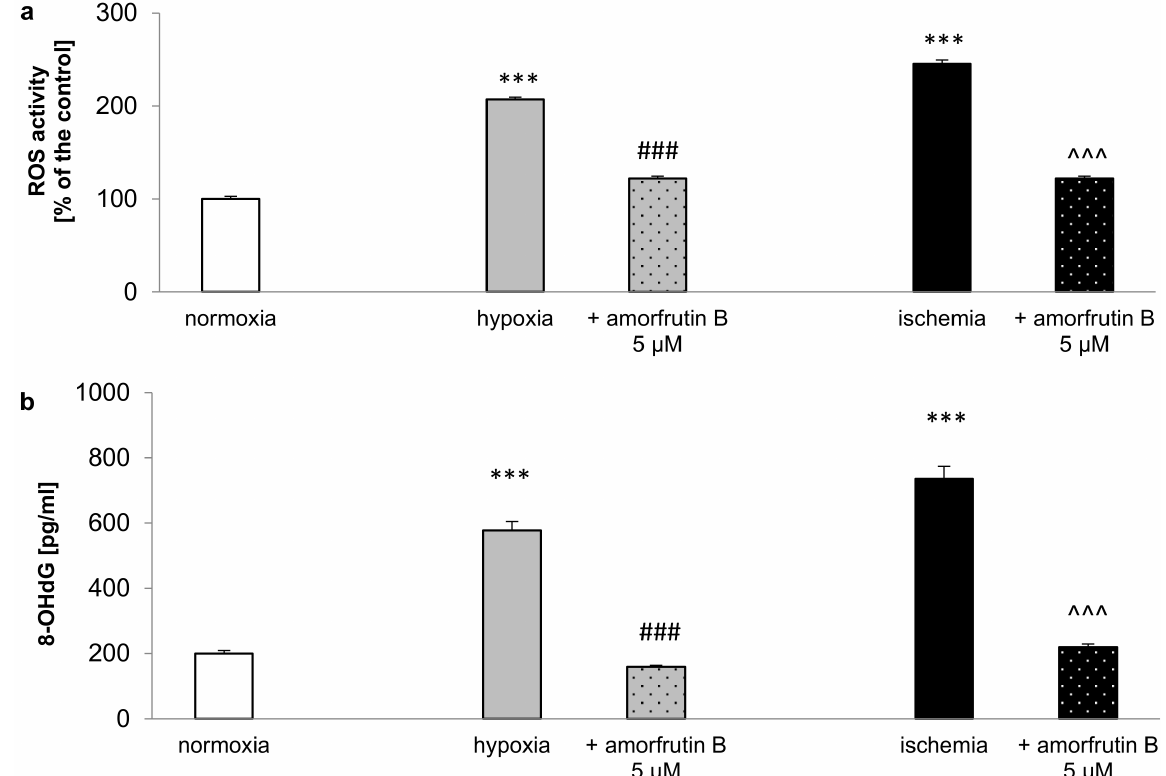
Figure 3. Amorfrutin B (5 µ M) post-treatment reduced the oxidative stress resulting from hypoxia and ischemia in neuronal cells. There was an increase in reactive oxygen species formation and 8-OHdG in the hypoxic and ischemic models, and amorfrutin B diminished the activity of these markers in both cases ( a , b ). The ROS activity results are presented as a percentage of the control ± SEM, and the 8-OHdG level results are presented as the mean ± SEM. There were 3 independent experiments, consisting of 10–12 replicates per group. *** p < 0.001 compared to the control group, ### p < 0.001 compared to the cultures exposed to hypoxia, ˆˆˆ p < 0.001 compared to the cultures exposed to